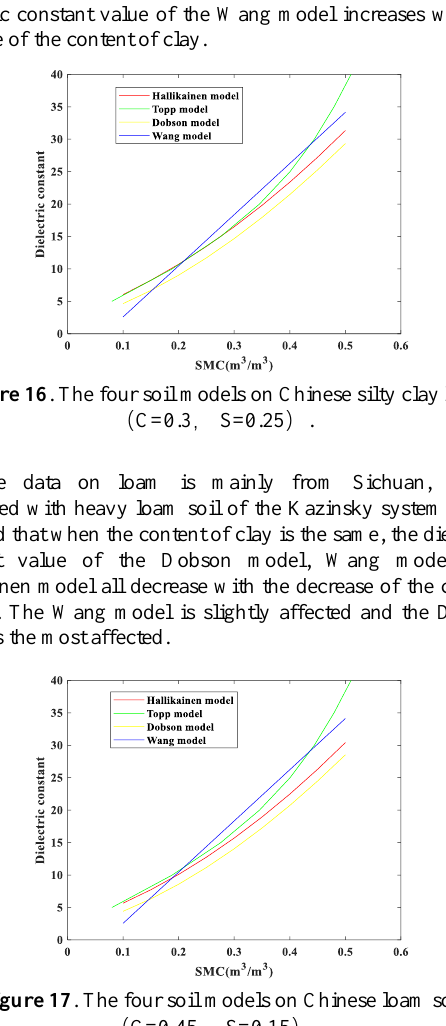
Figure 18. Effects of clay on soil dielectric constant.